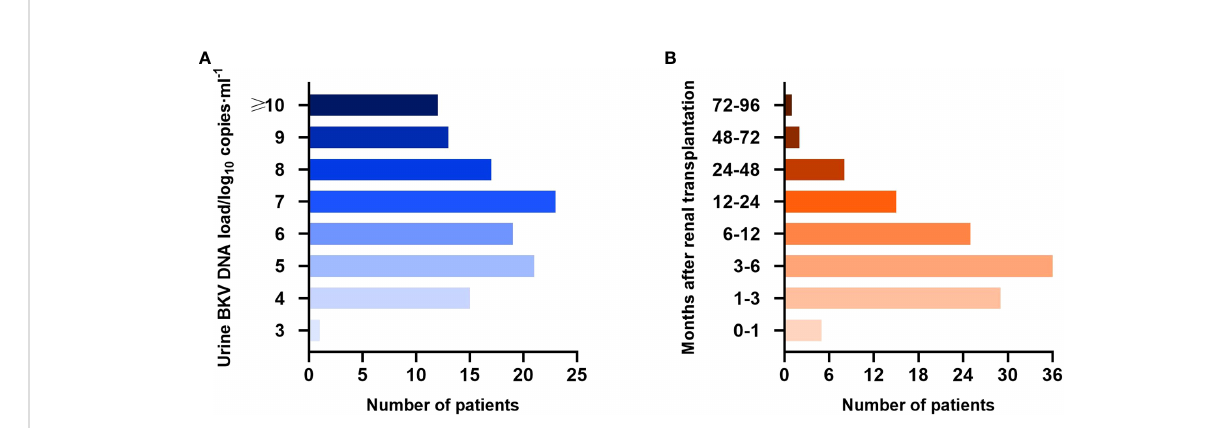
FIGURE 2 Urine BK polyomavirus (BKV) DNA load (A) and time distribution of urine BKV DNA positivity for the fi rst time (B) in the BKV-positive group.